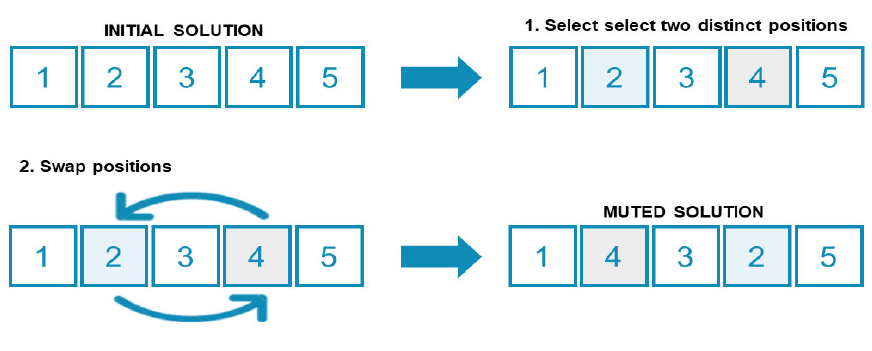
Fig. 5. An example of the swap